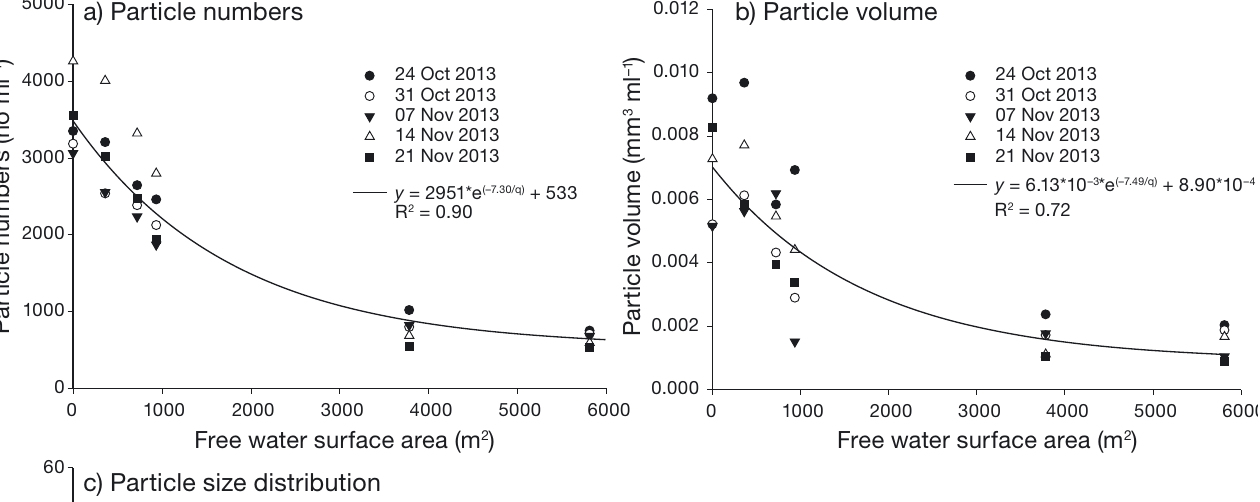
Fig. 3. Observed and modelled (a) numbers and (b) volume of particles measured in grab samples obtained along the wetland at 5 consecutive sampling dates in October and No- vember 2013, with q in the equations referring to the hori- zontal flow velocity cf. Table 1; and (c) the average relative size distribution of particle measured at the wetland inlet (Stn C, hydraulic retention time of 0.00 d) and outlet station (Stn F, hydraulic retention time of 0.32 d), respectively. As- terisks indicate that the 2 stations were significantly differ- ent ( t -test, p < 0.05); ‘ND’ denotes that the power of the test was less than desired and a t -test therefore